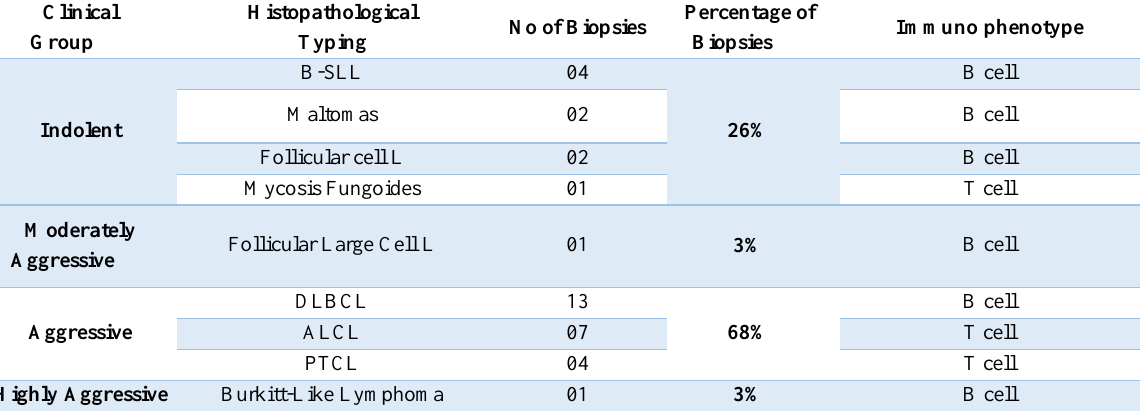
Table 4. Histopathological and Immuno phenotypic Subtyping of Non Hodgkin Lymphomas (Clinical Groupings)